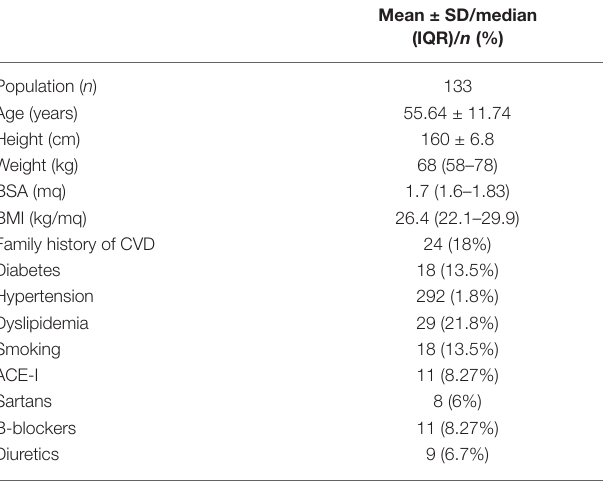
TABLE 1 | General characteristics of the study